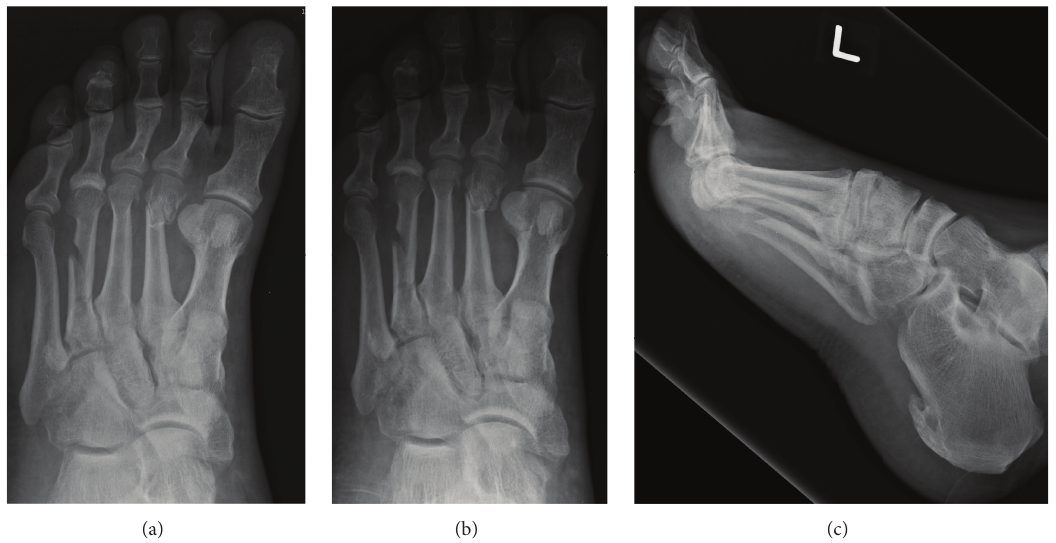
Figure 1: Dorsoplantar (a), oblique (b), and lateral (c) radiographs of the left foot at initial presentation.